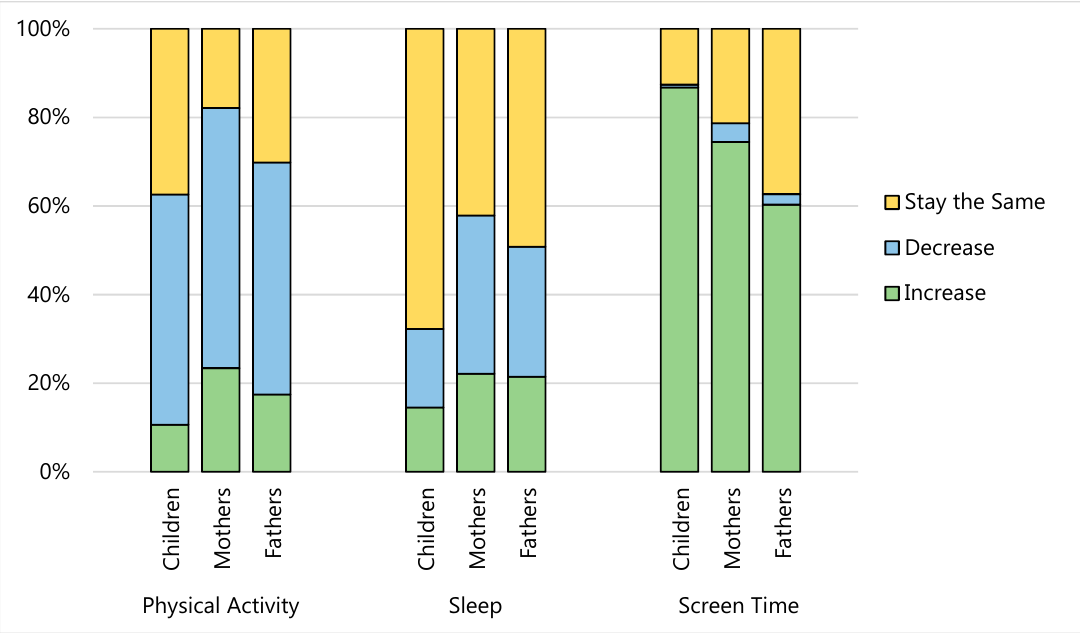
Figure 3. Change in physical activity, sleep and screen time behaviours among mothers ( n = 235), fathers ( n = 126), and children ( n = 310) since COVID-19.